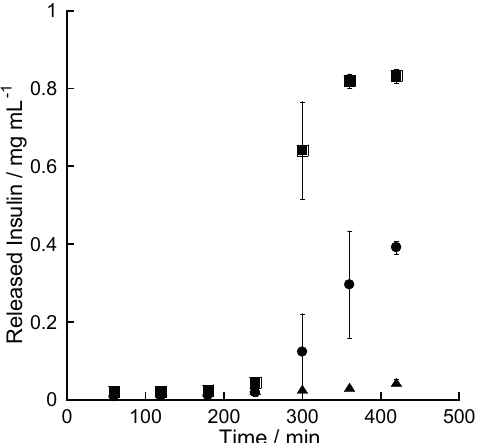
Figure 1. Amount of insulin released from uncoated CaCO solutions at pH 6.0 ( ■ ), 7.4 ( ● ), and 9.0 ( ▲ ). Average values of three measurements are